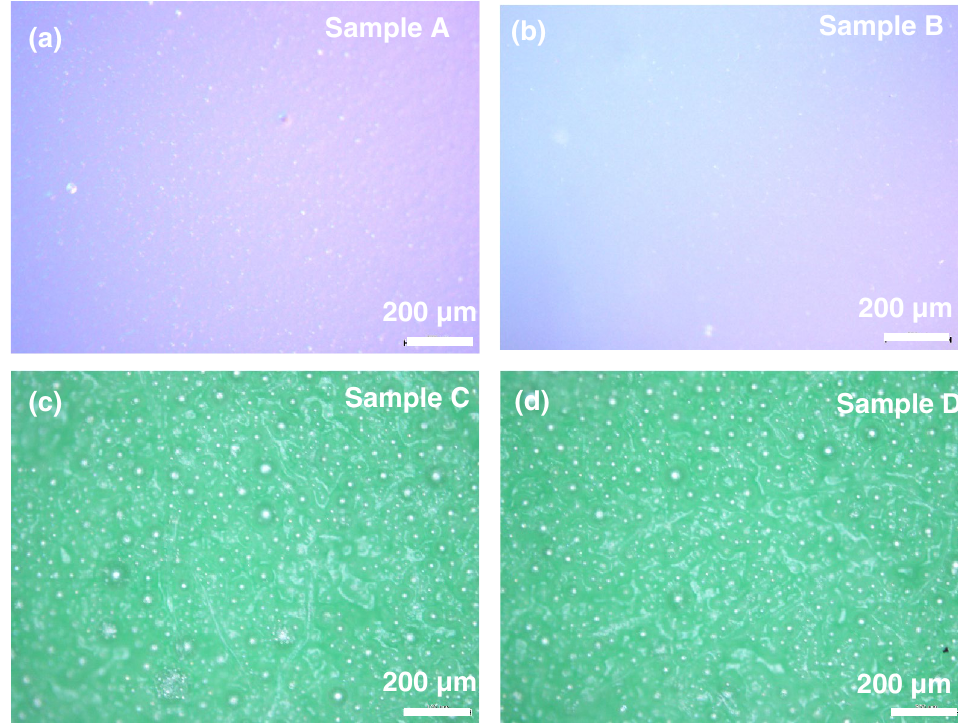
Figure 2. Optical microscopy images for: ( a ) baseline (Sample A), ( b ) baseline and shaving cream (Sample B), ( c ) baseline with clay (Sample C), and ( d ) baseline with shaving cream and clay (sample